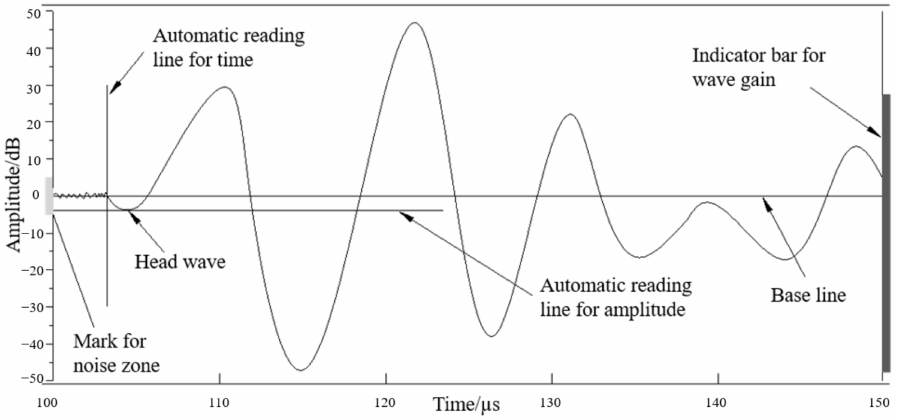
Figure 4. Schematic waveform diagram in